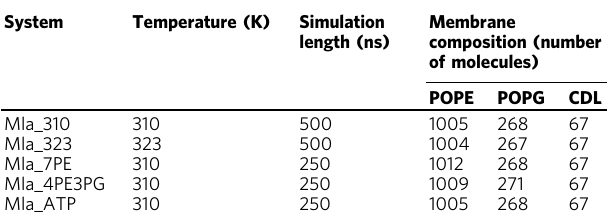
Table 2 A summary of the MD simulations presented in this